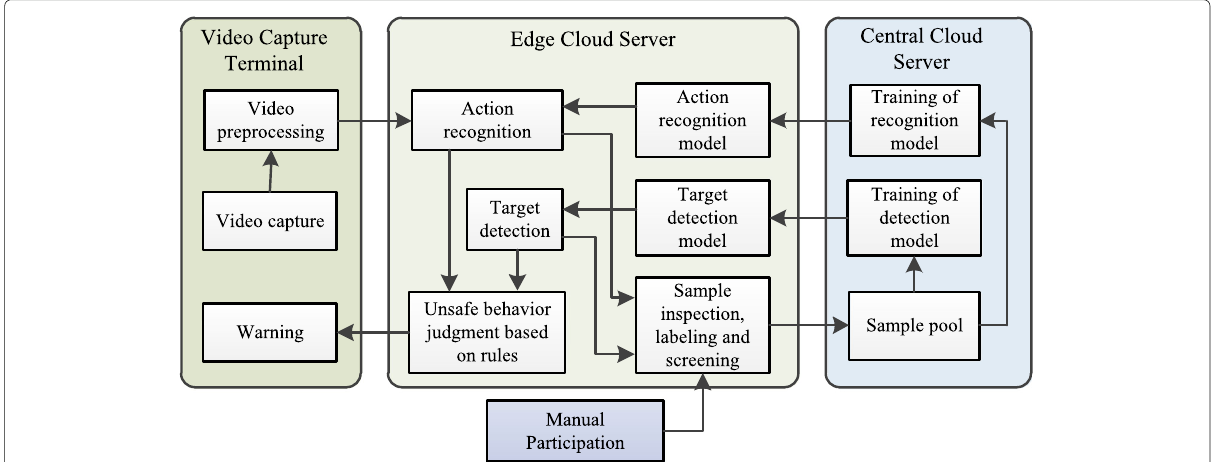
Fig. 1 Prediction framework of unsafe actions in power operation based on edge